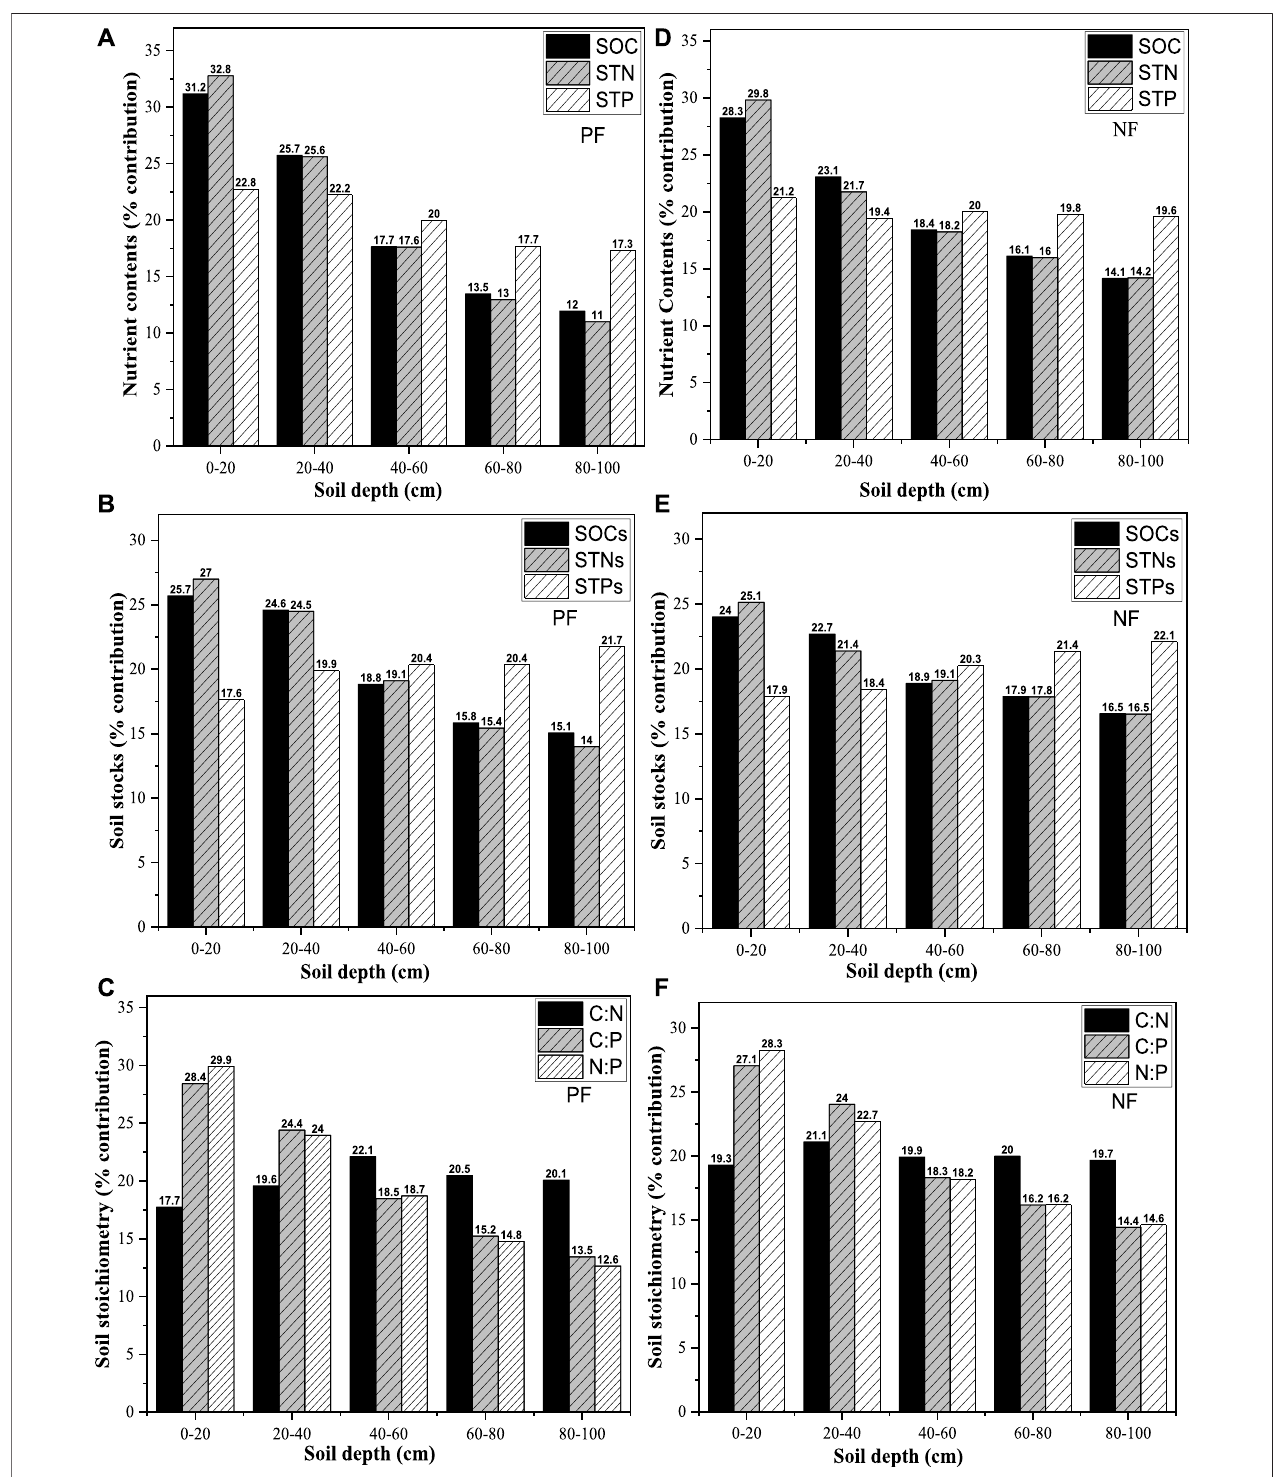
FIGURE 4 | Percent contribution per soil depth to overall average contents, stocks, and stoichiometry of SOC, TN, and TP for PF (A – C) and NF (D – F) .